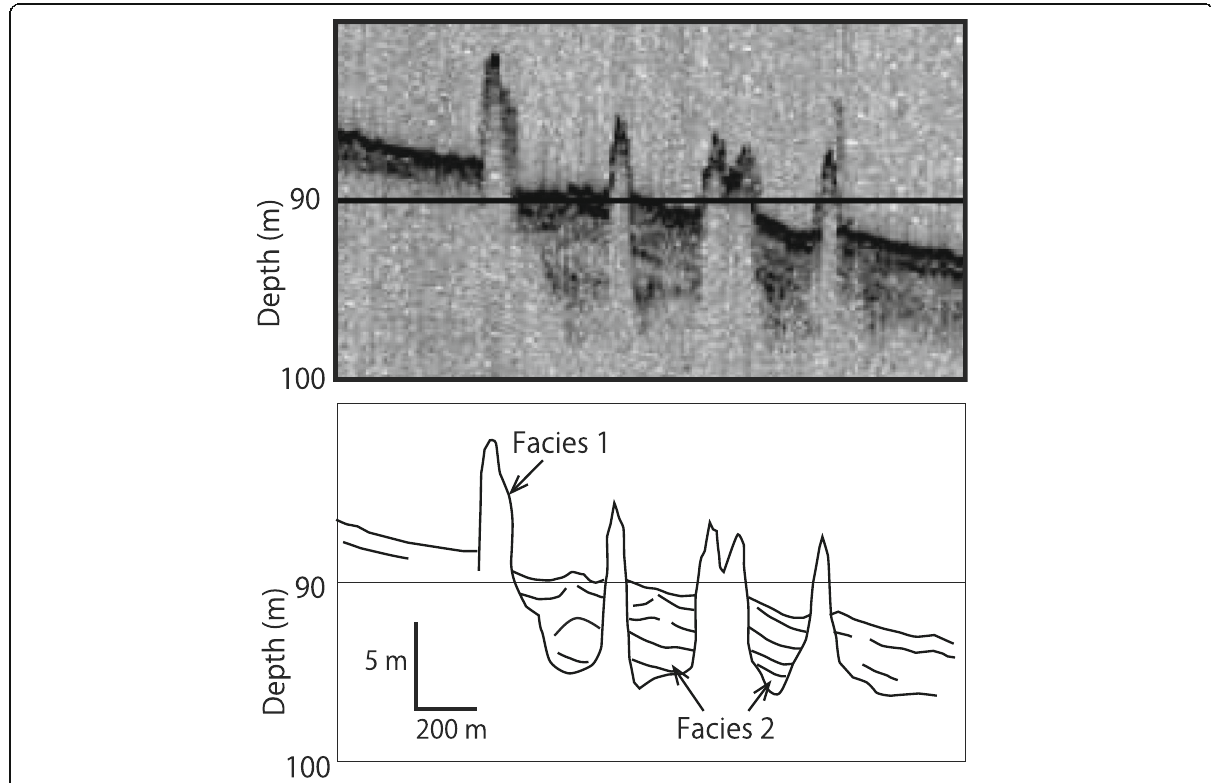
Fig. 5 SBP profile and corresponding schematic diagram showing the relationship between Facies 1 and Facies